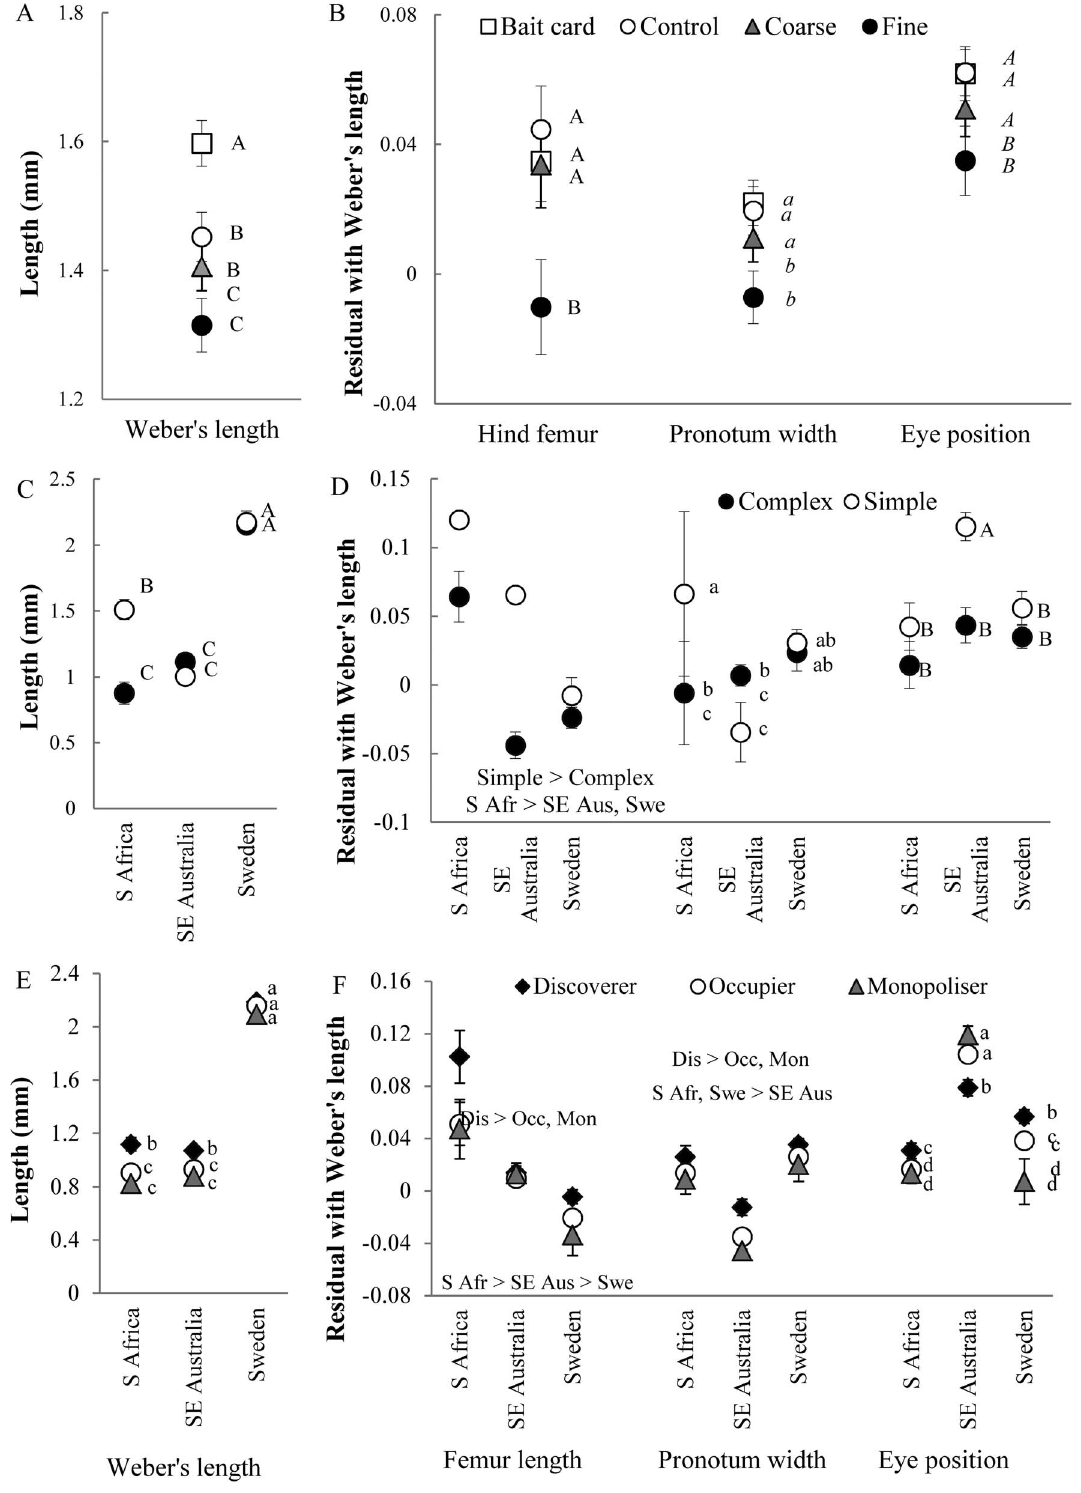
Figure 1. Mean ± SE measures for morphological traits of ants that were first to discover baits (‘discoverer’) in experimental treatments . a) Weber’s length; and b) residuals of hind femur, pronotum width and eye position with Weber’s length; ants that were first to discover baits in natural habitats among regions : c) Weber’s length; and d) residuals of hind femur, pronotum width and eye position with Weber’s length; and comparing species that were first to discover a resource, those that occupied it at 3 hours and those that monopolised it for: e) Weber’s length; and f) residuals of hind femur, pronotum width and eye position with Weber’s length. Different letters indicate significantly different means. Results for ants occupying and monopolising resources at three hours were similar to those that were first to discover them (Figs. S4,5).